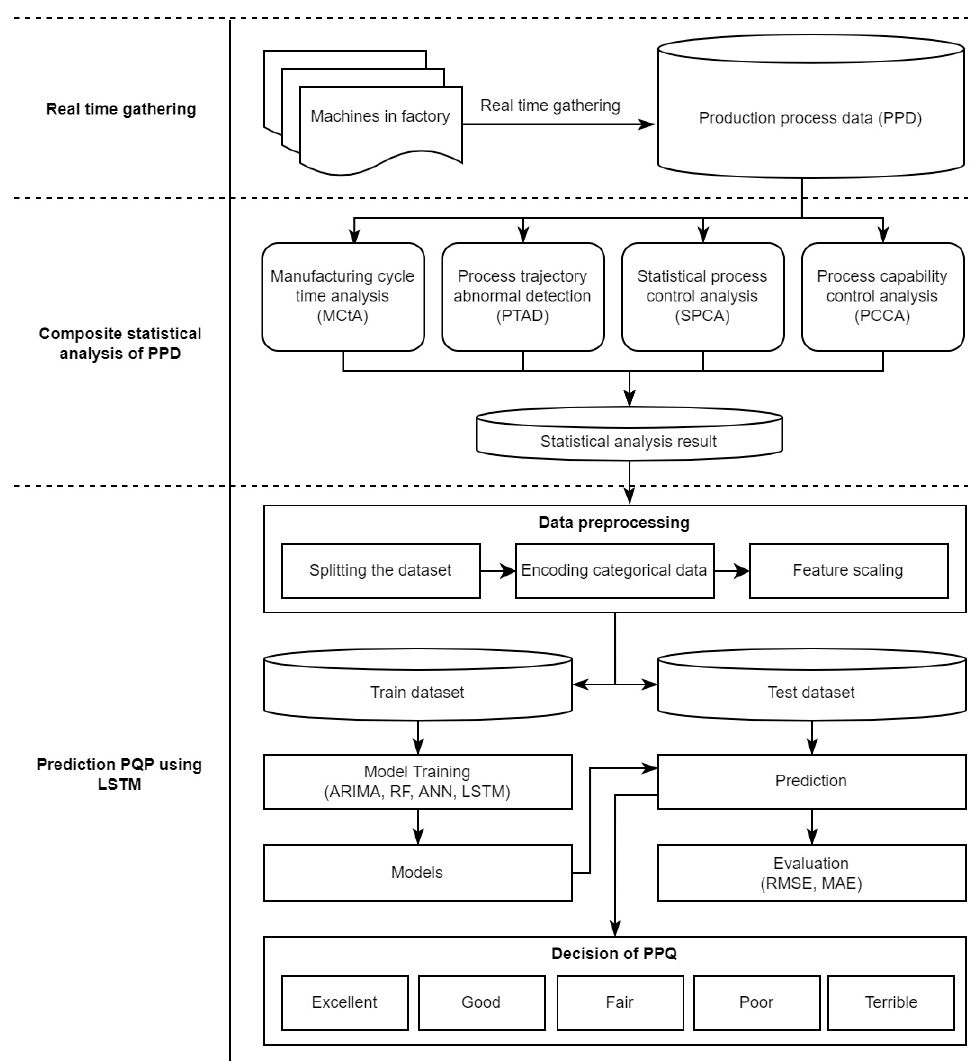
Figure 1. Overall flow of the proposed system.